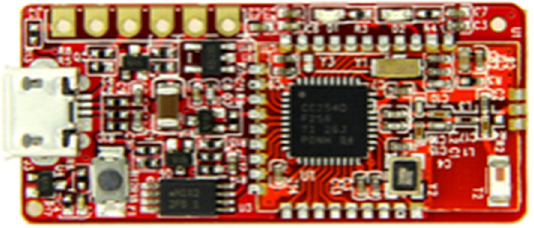
Figure 15. TI CC2540 Module (Using Scenario 2).